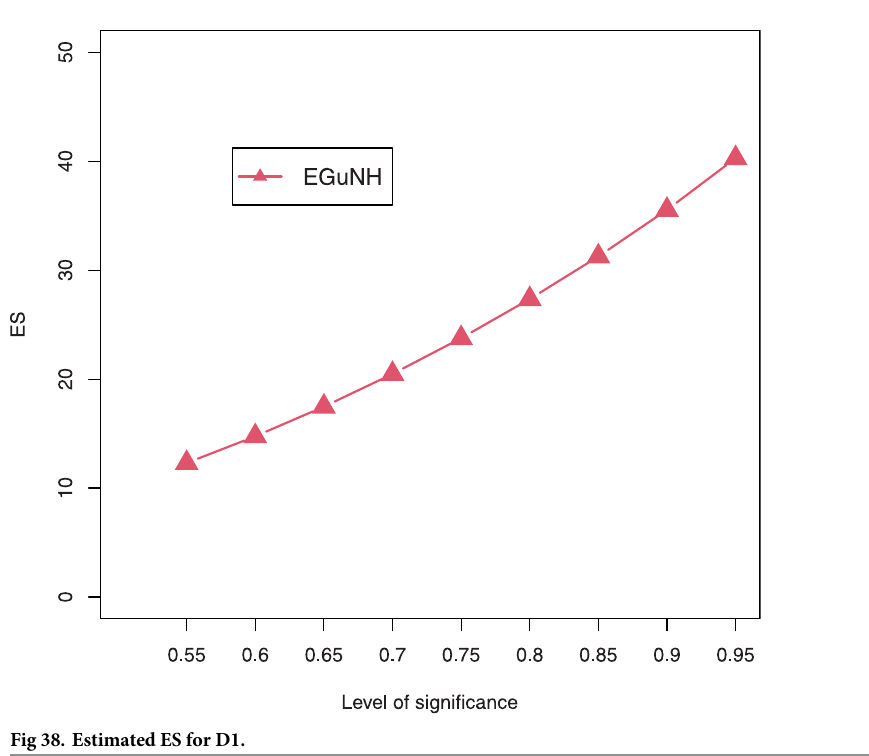
Fig 38. Estimated ES for D1.